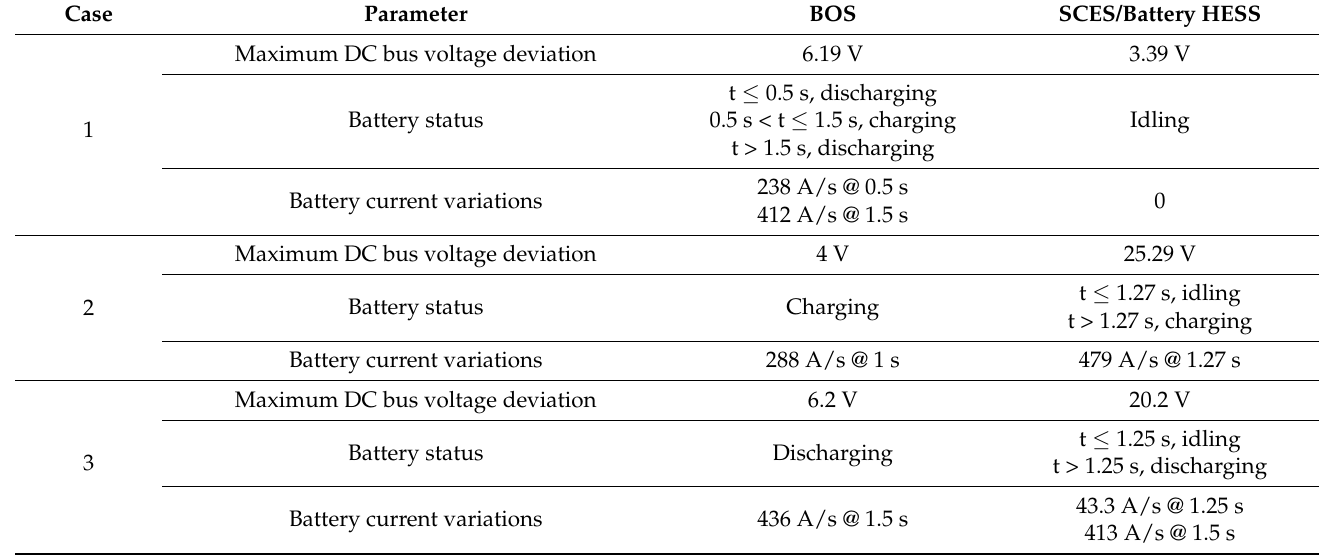
Table 6. Comparison among the previous assessments in the presence of a BOS and a SCES/battery HESS controlled with the proposed